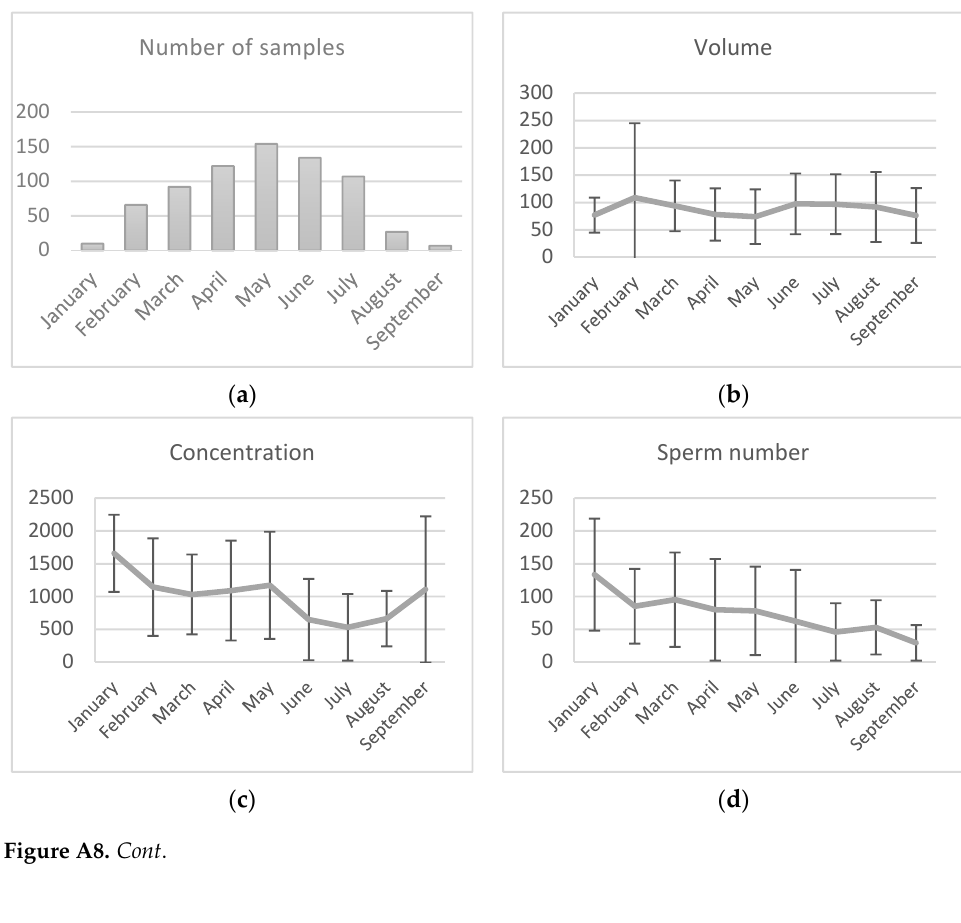
Figure A7. Frequency distribution of egg records and semen collection in captive Arabian bustard throughout the year at the National Avian Research Center (Sweihan, UAE).